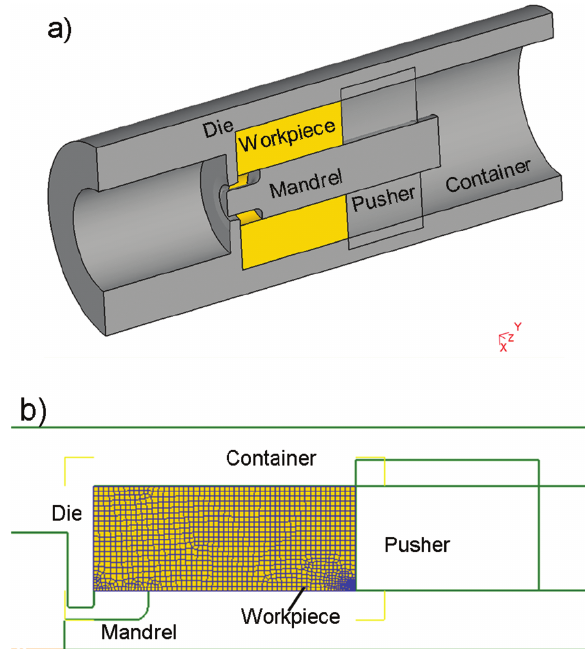
Figure 3: Schematic diagram (a) and FEM model (b) of the workpiece and